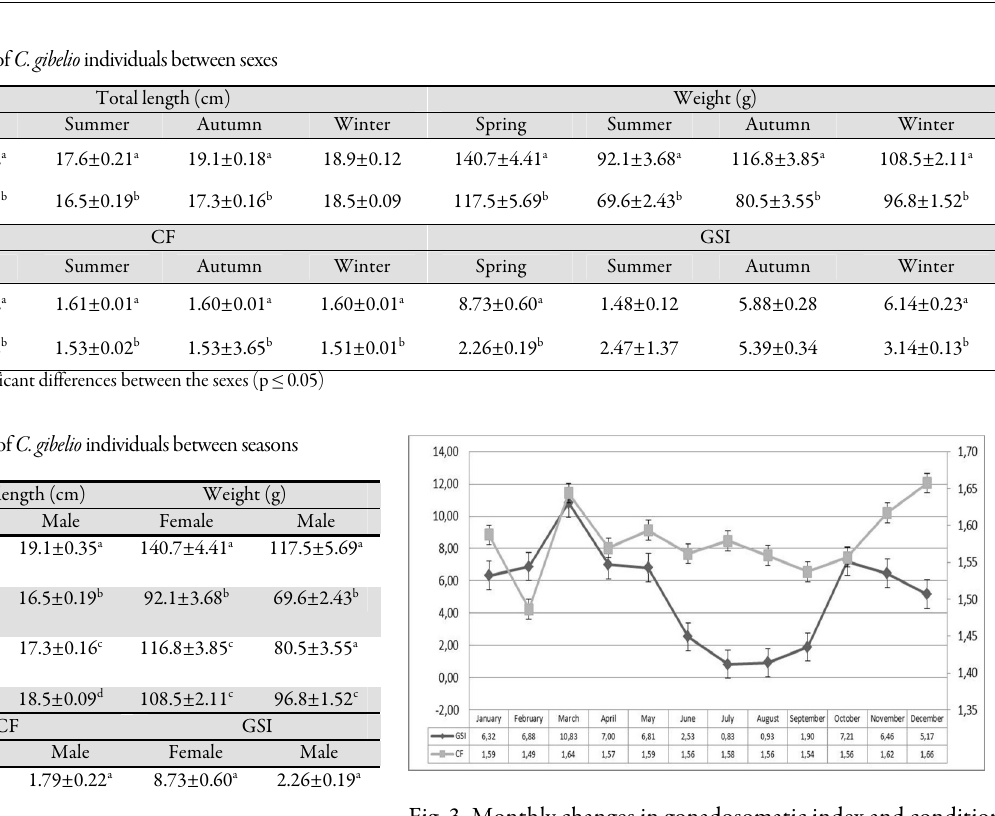
Fig. 3. Monthly changes in gonadosomatic index and condition factors of for female C. gibelio in the Beyşehir growth features of C. gibelio in a mesotrophic reservoir.